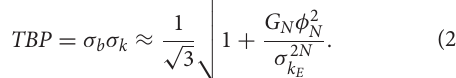
φ N σ N b / N !. Results are predicted from =